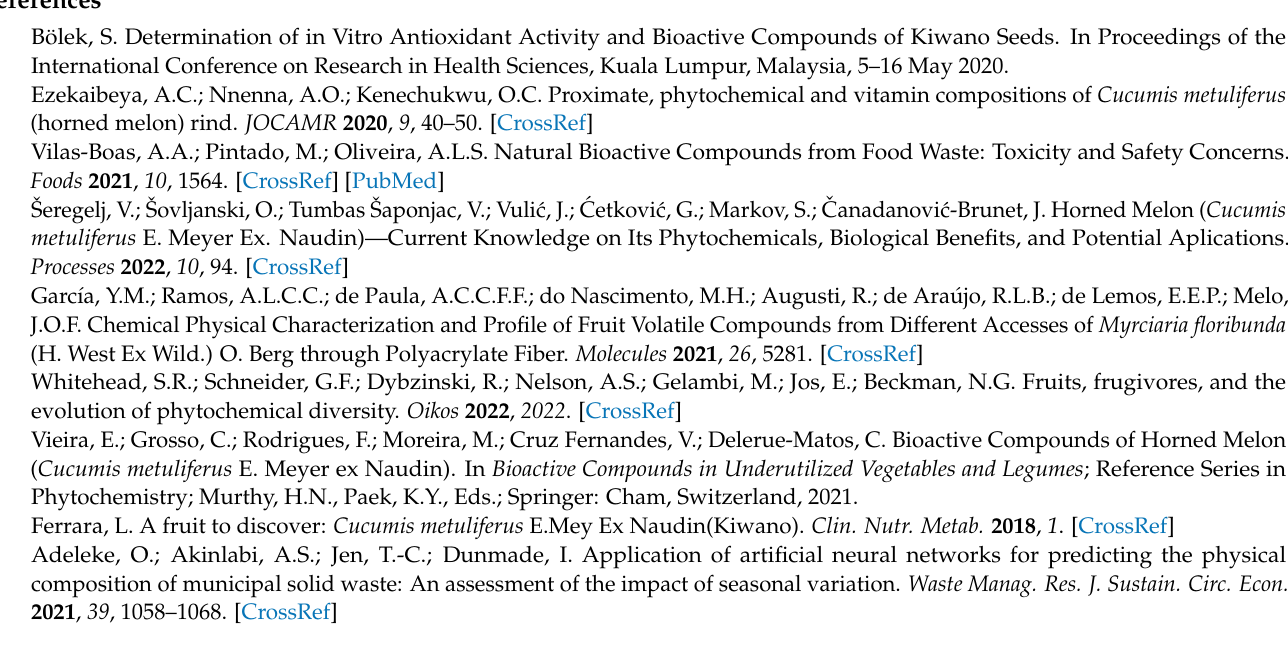
Table S1: The effect of controls during the disk diffusion